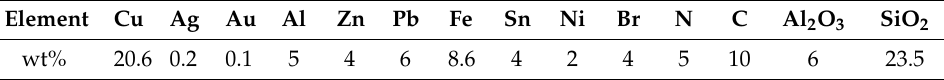
Table 2. Chosen compositions of PCB employed in the input, as published by Ghodrat et al. [25].